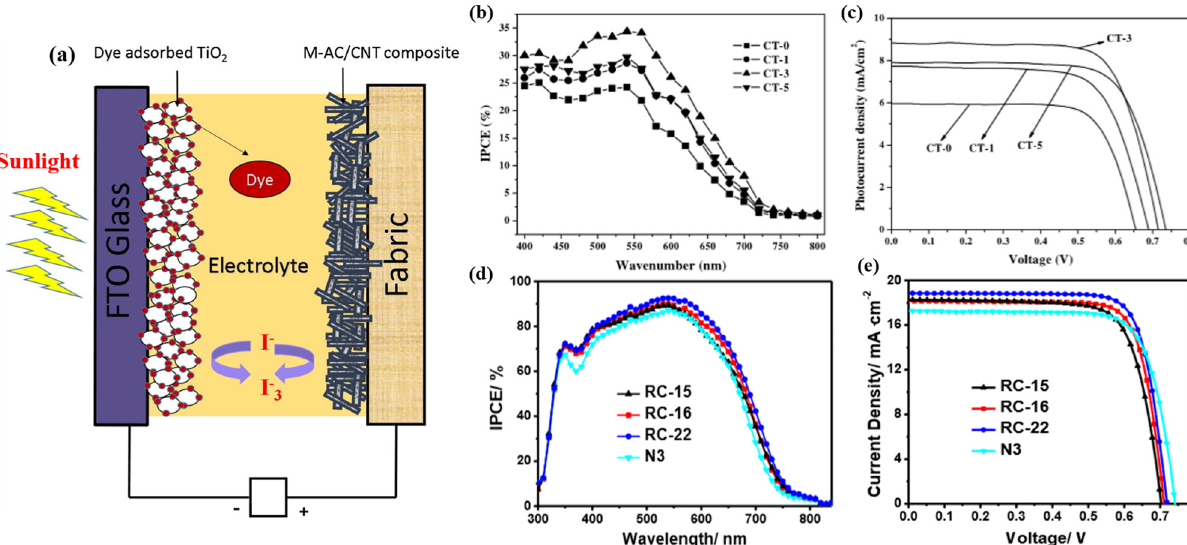
Figure 12: ( a ) Schematic of the working principle for the DDSC [ 90 ] . Copyright 2017 International Solar Energy Society. ( b ) Comparison of cyclic voltammetry of conventional Pt and as - synthesized aligned - CNT and mesoporous - activated charcoal ( M - AC ) /VACNT composite. ( c ) Current – voltage curves of the DDSC based on VACNT/TiO [ 91 ] . Copyright 2008 Institute of Physics Publishing. 2 composite electrodes ( d ) The incident - photo - to - current e ffi ciency conversion spectra for DSSCs sensitized with the VACNT - based composite electrodes. ( e ) Current – voltage curves of DSSCs [ 92 ] . Copyright, 2016, Royal Society of